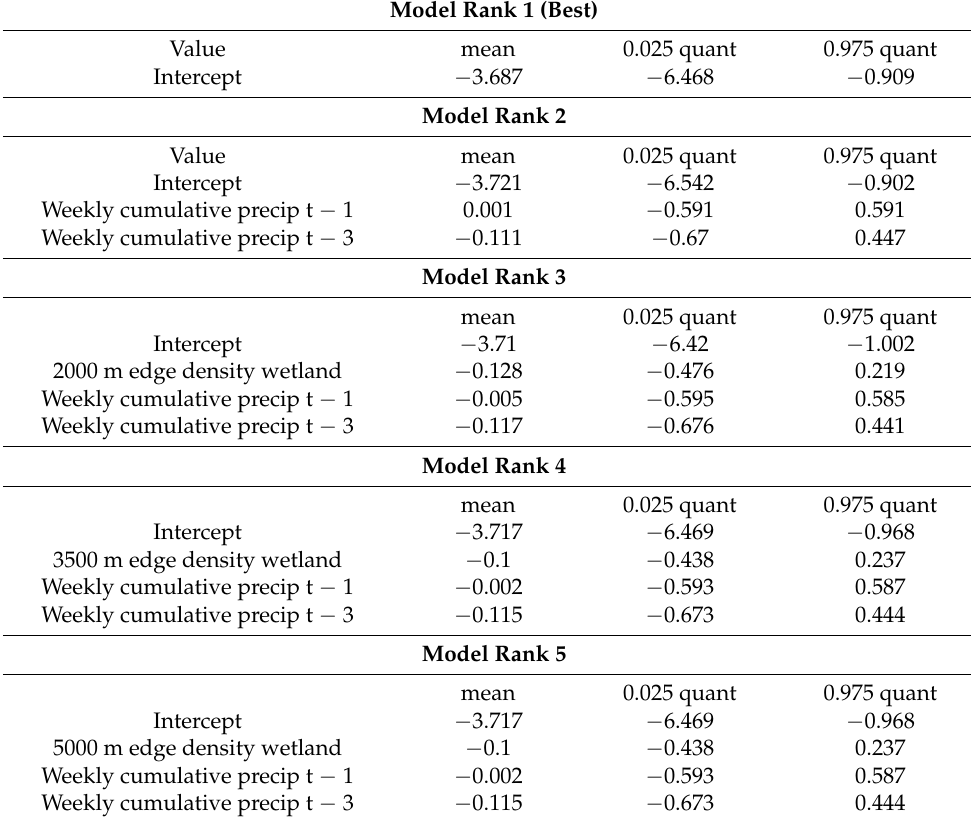
Table 4. The credible intervals for the WNV 95% confidence set. No variable had a strong effect on WNV seroconversion. The sign of the mean indicates a positive or negative effect. If values cross zero between the 0.025 quant and the 0.975 quant, the variable has no effect on seroconversion.